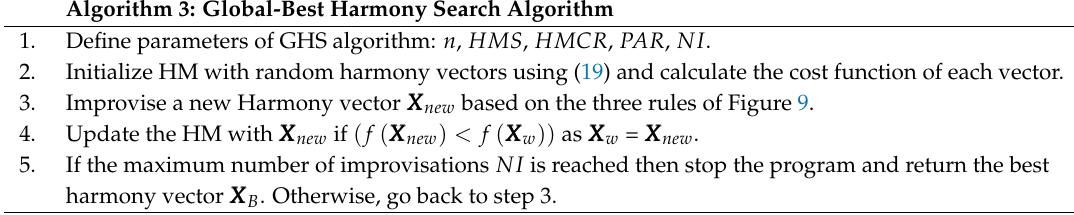
Algorithm 3: Global-Best Harmony Search